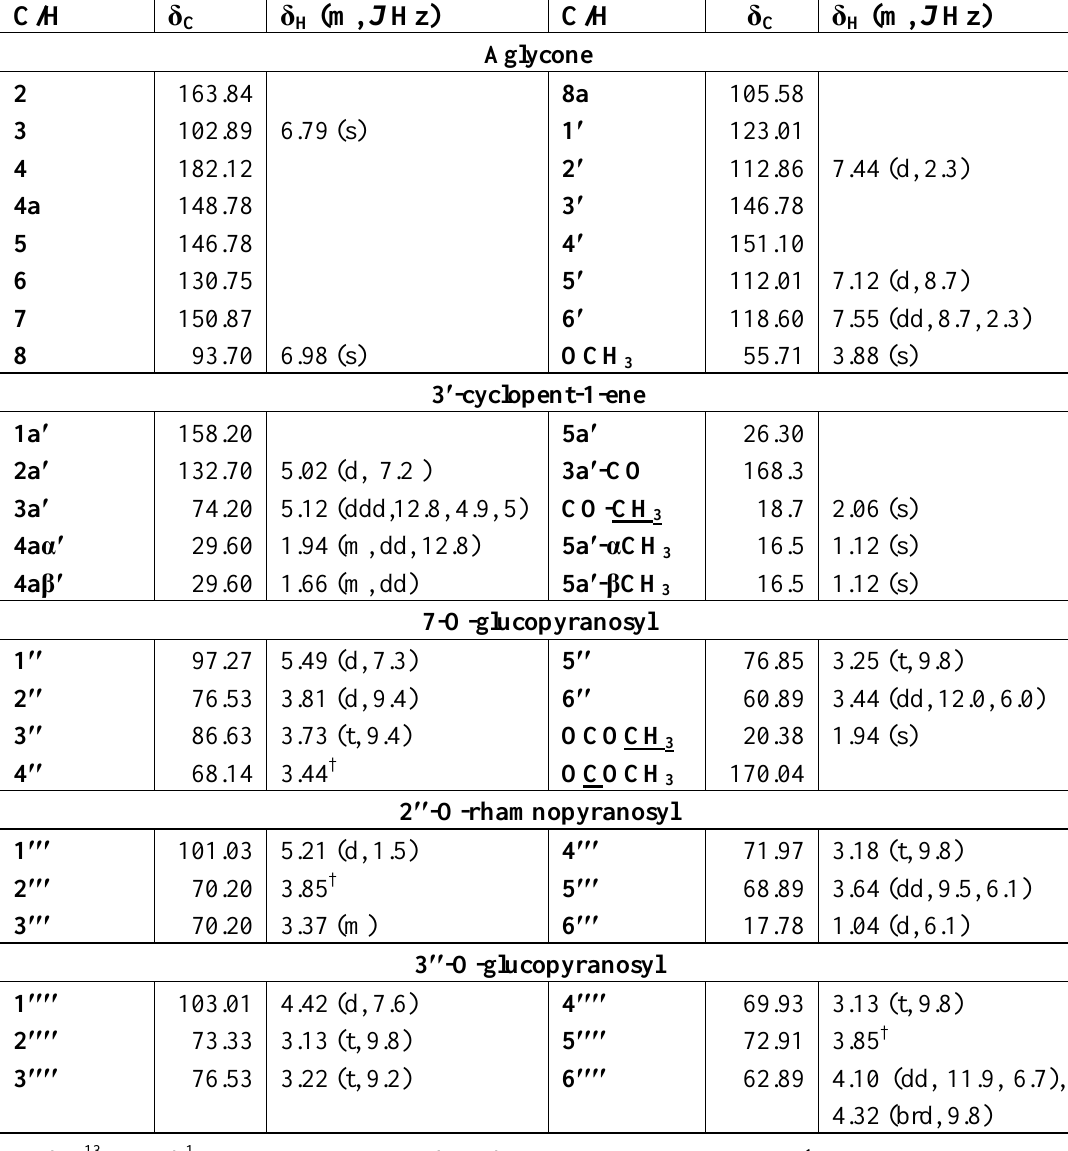
Table 1 . 13 C- (125 MHz) and 1 H-NMR (500 MHz) spectral data for KSR1 * (D